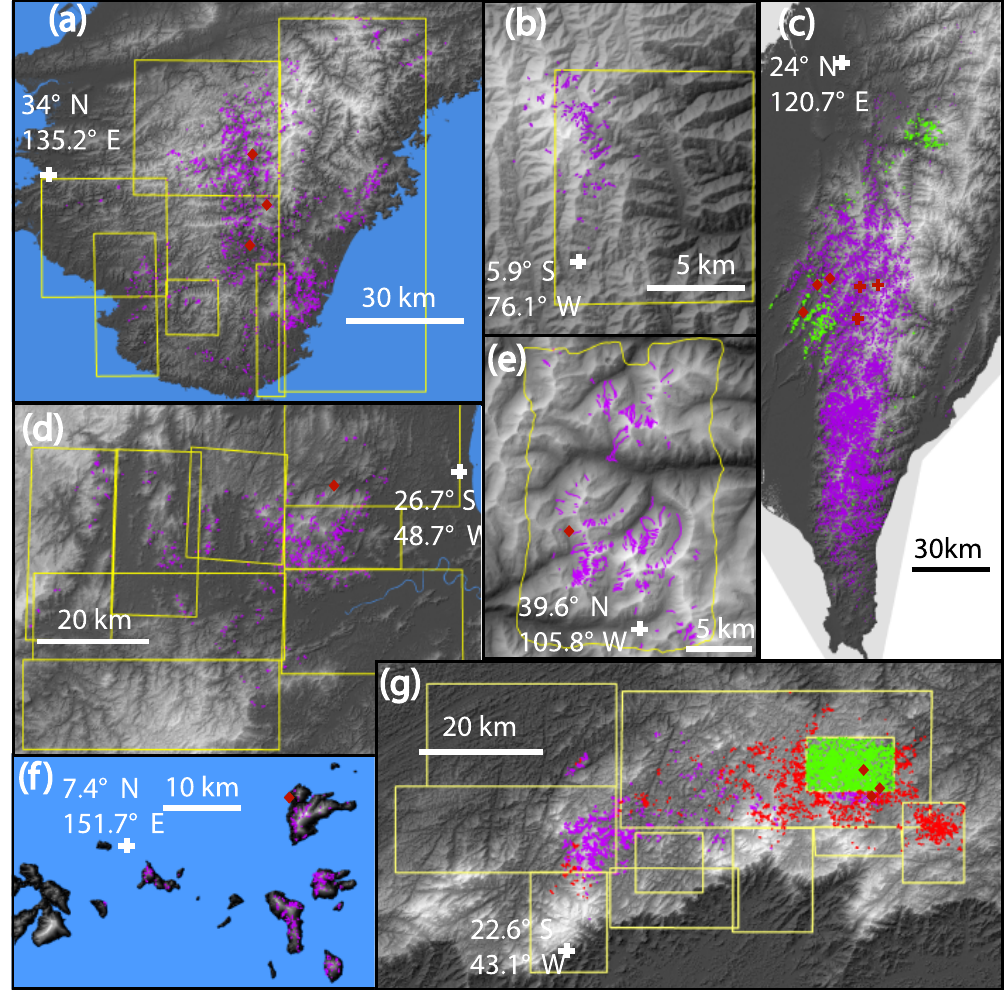
Figure 1. Landslides inventory superimposed on digital surface model for the events in Japan 2011 (a) , Colombia 2015 (b) , Taiwan 2008 and 2009 (c) , Brazil 2008 (d) , Colorado 1999 (e) , Micronesia 2002 (f) and Brazil 2011 (g) . Landslides are in purple, rain gauges used in this study are in red dots (and red crosses for Taiwan 2009), and the yellow frames show the availability of high-resolution imagery (Google Earth) used to check or perform the mapping. In (c) the green dots are landslides from 2008, while purple dots are from 2009. In (g) purple, red, and green dots are landslides mapped from EO-ALI, Google Earth, and automatic classification of GeoEye images,